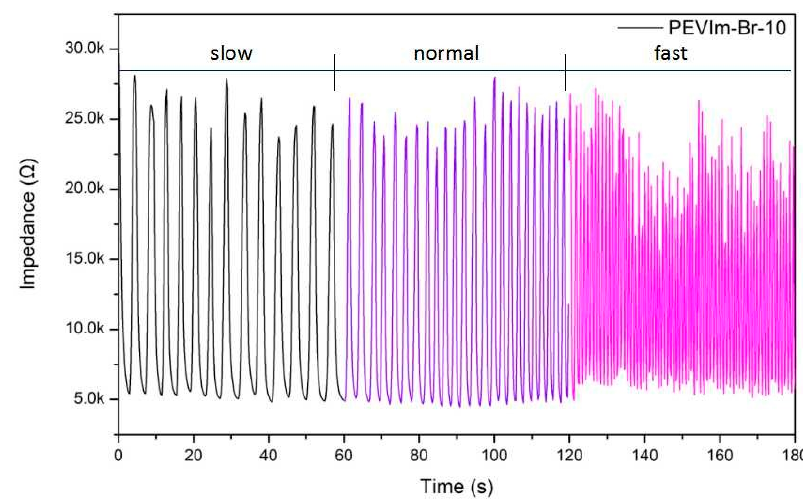
Figure 11. Response of the sensor based on PIL-Br-10 at varying respiratory rates at the working frequency (500 Hz).